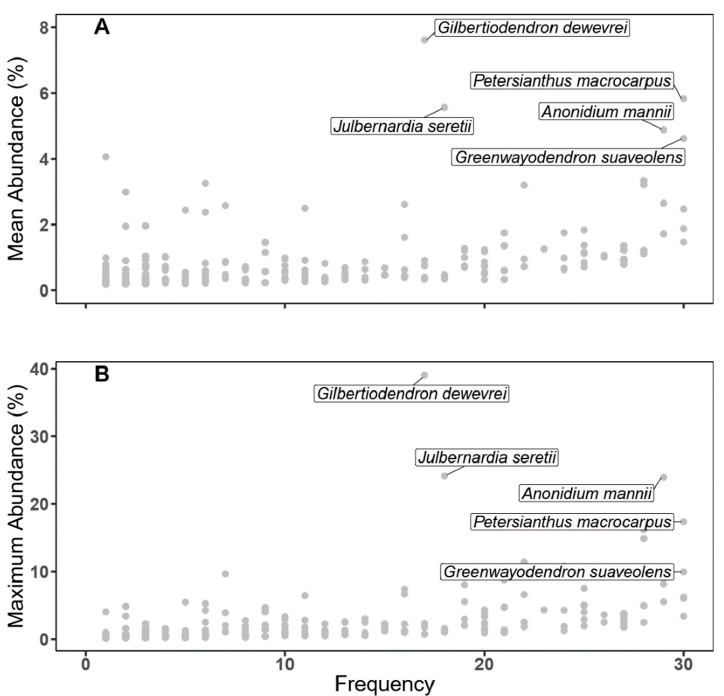
Figure 2. Mean and maximum local relative abundance against species frequency of occurrence in the 30 1-ha plots. ( A ) Mean local relative abundance (only accounting for plots where the species is present) and ( B ) maximum local relative abundance. Only species frequencies > 18, mean abundance > 4.5 and max abundance > 10 are shown for legibility. Forests 2020 , 10 , x FOR PEER REVIEW Four species ( J. seretii , G. dewevrei, P. macrocarpus and A. mannii ) characterized three major (NSCA), as shown in Figure 3A. The first two compositional axes of the NSCA together constituted 48.25 % of the total floristic variance. The first axis (negative side) was clearly pulled by G. dewevrei while the second axis opposed plots dominated by P. macrocarpus (positive side) and J . seretii and A. mannii on the negative side.